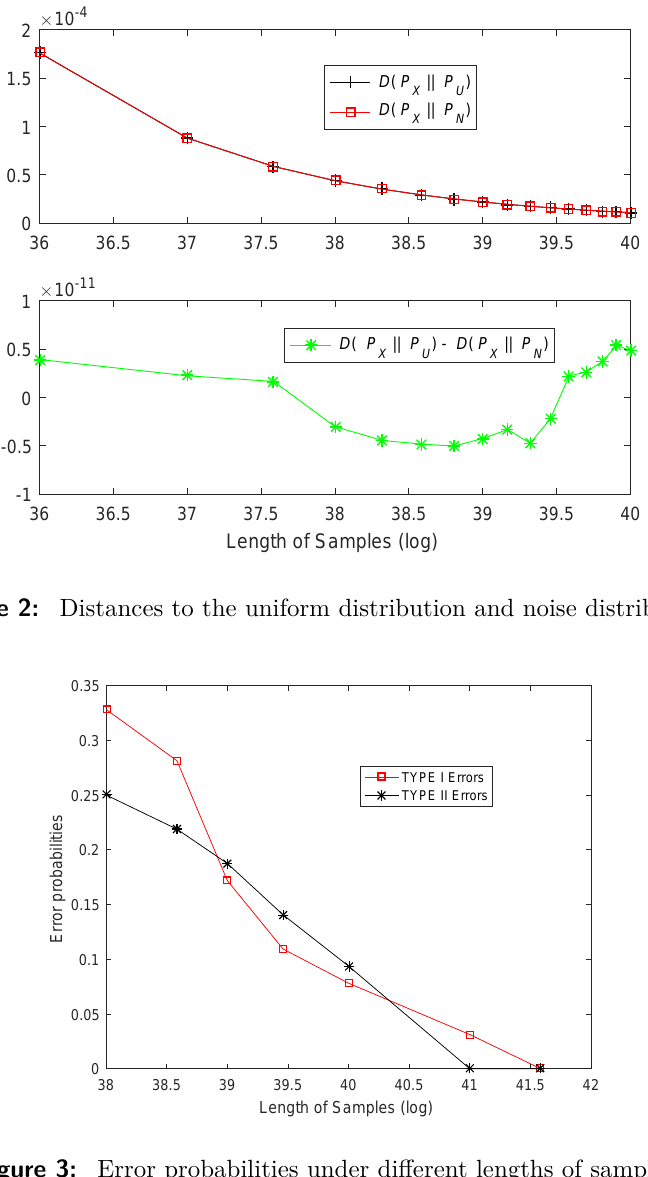
Figure 3: Error probabilities under different lengths of